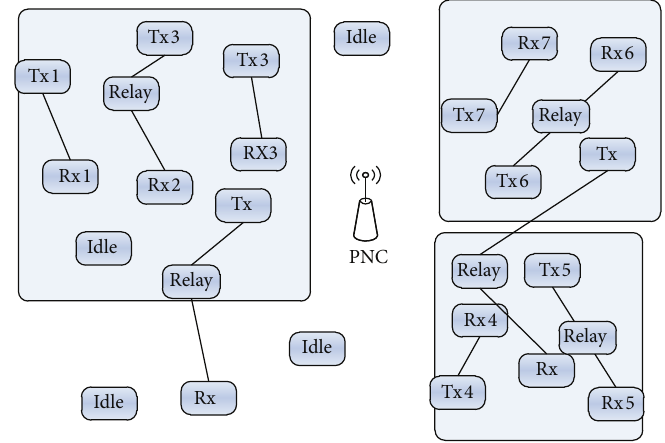
Figure 1: System Model for Typical D2D